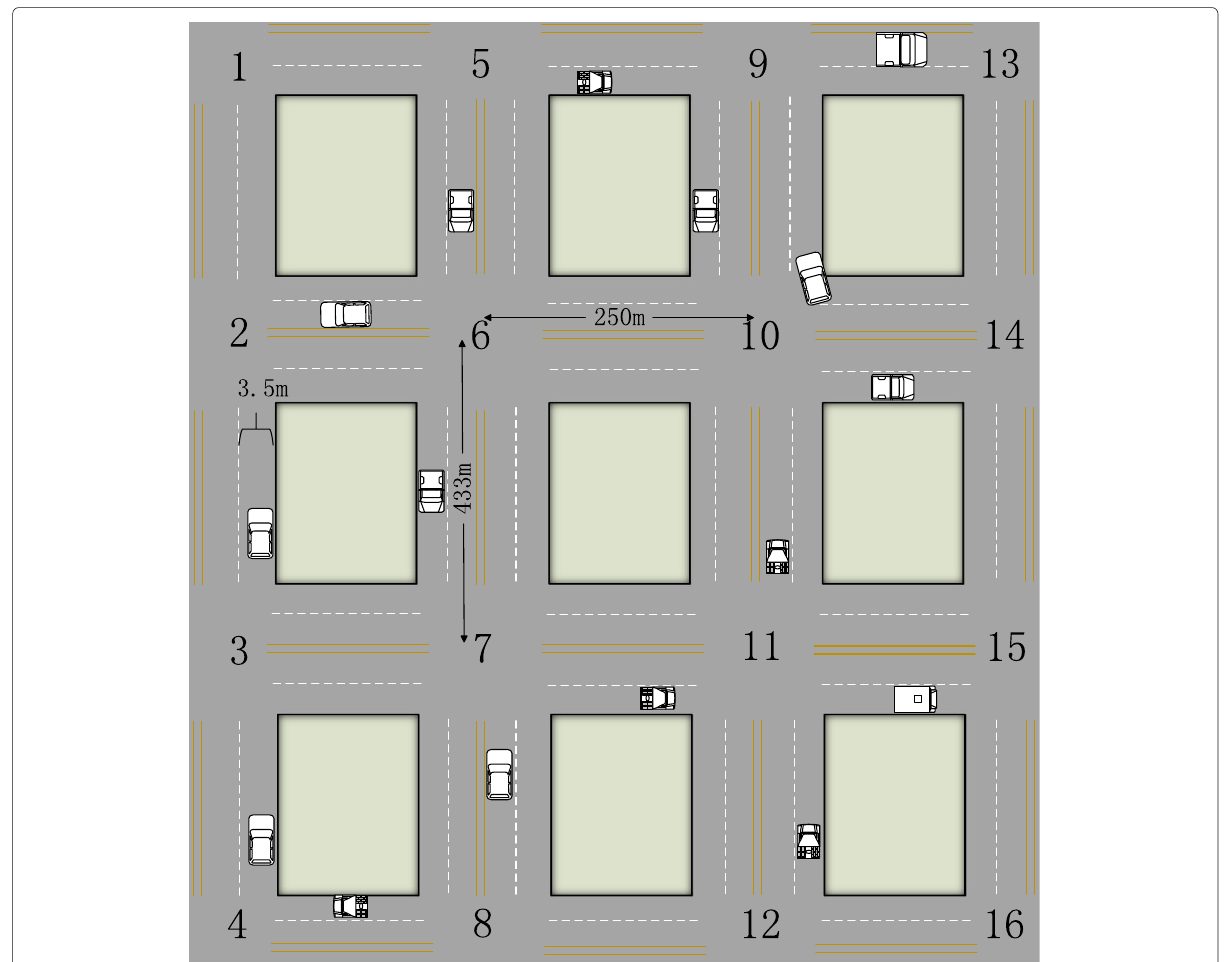
Fig. 11 System model for a Manhattan urban scene. Numbers in this figure are the labels of geographic areas